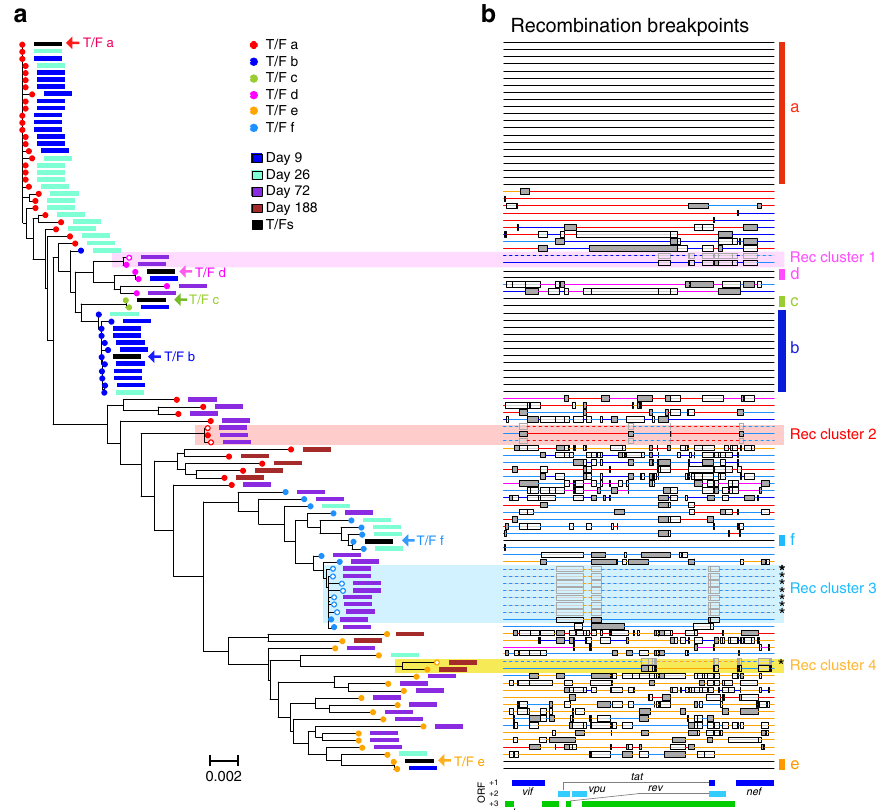
Fig. 2 Identi fi cation of recombinants by RAPR. a Phylogenetic tree of 3 ′ half genome sequences from longitudinal samples from CH0010. Shaded regions show clonal expansion events and are color coded to indicate their closest T/F lineage. In each cluster, solid circle represents the originating (de novo) recombinant for that cluster and open circles represent its recombinant descendants. b Recombination breakpoints. Each line represents a sequence, and colored lines represent recombinants. Colored intervals in each recombinant sequence indicate the parental T/F lineage. Black boxes indicate the interval where the breakpoints are most likely to have occurred, and when the breakpoints are statistically signi fi cant, the box is shaded in gray. Shaded regions show clonal expansion events and are color coded to indicate their closest T/F lineage. Dashed lines indicate recombination descendants derived from a particular de novo recombinant as shown as a solid line in the same shaded group. The black stars on the right indicate the sequence lineage that RAPR identi fi ed as descendants of a single recombination event, while the program RECCO failed to recognize it as